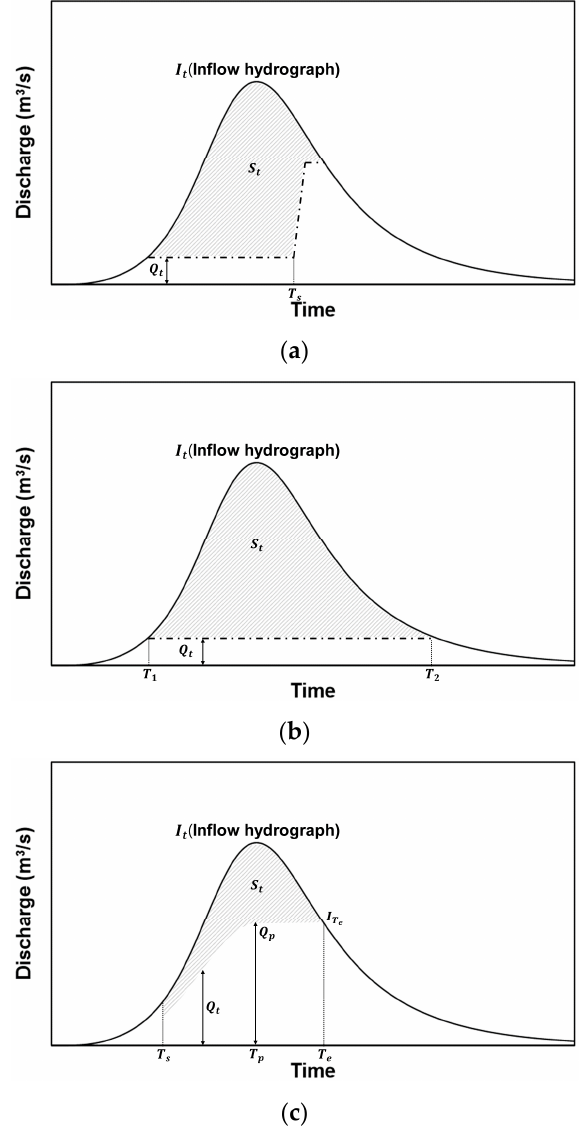
Figure 3. Comparison of three reservoir operation methods (ROMs). The discharge Q t is differently determined depending on the adopted ROM. ( a ) Auto ROM; ( b ) Technical ROM; ( c ) Rigid ROM.